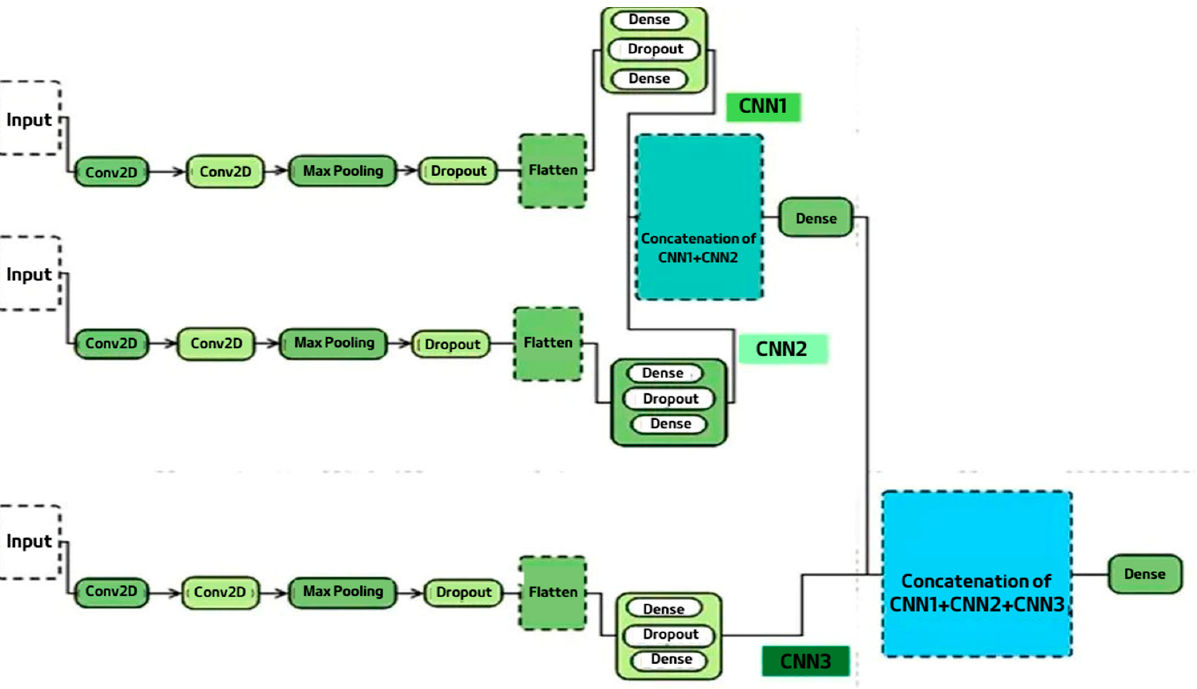
Figure 4. 3-CNN model architecture.